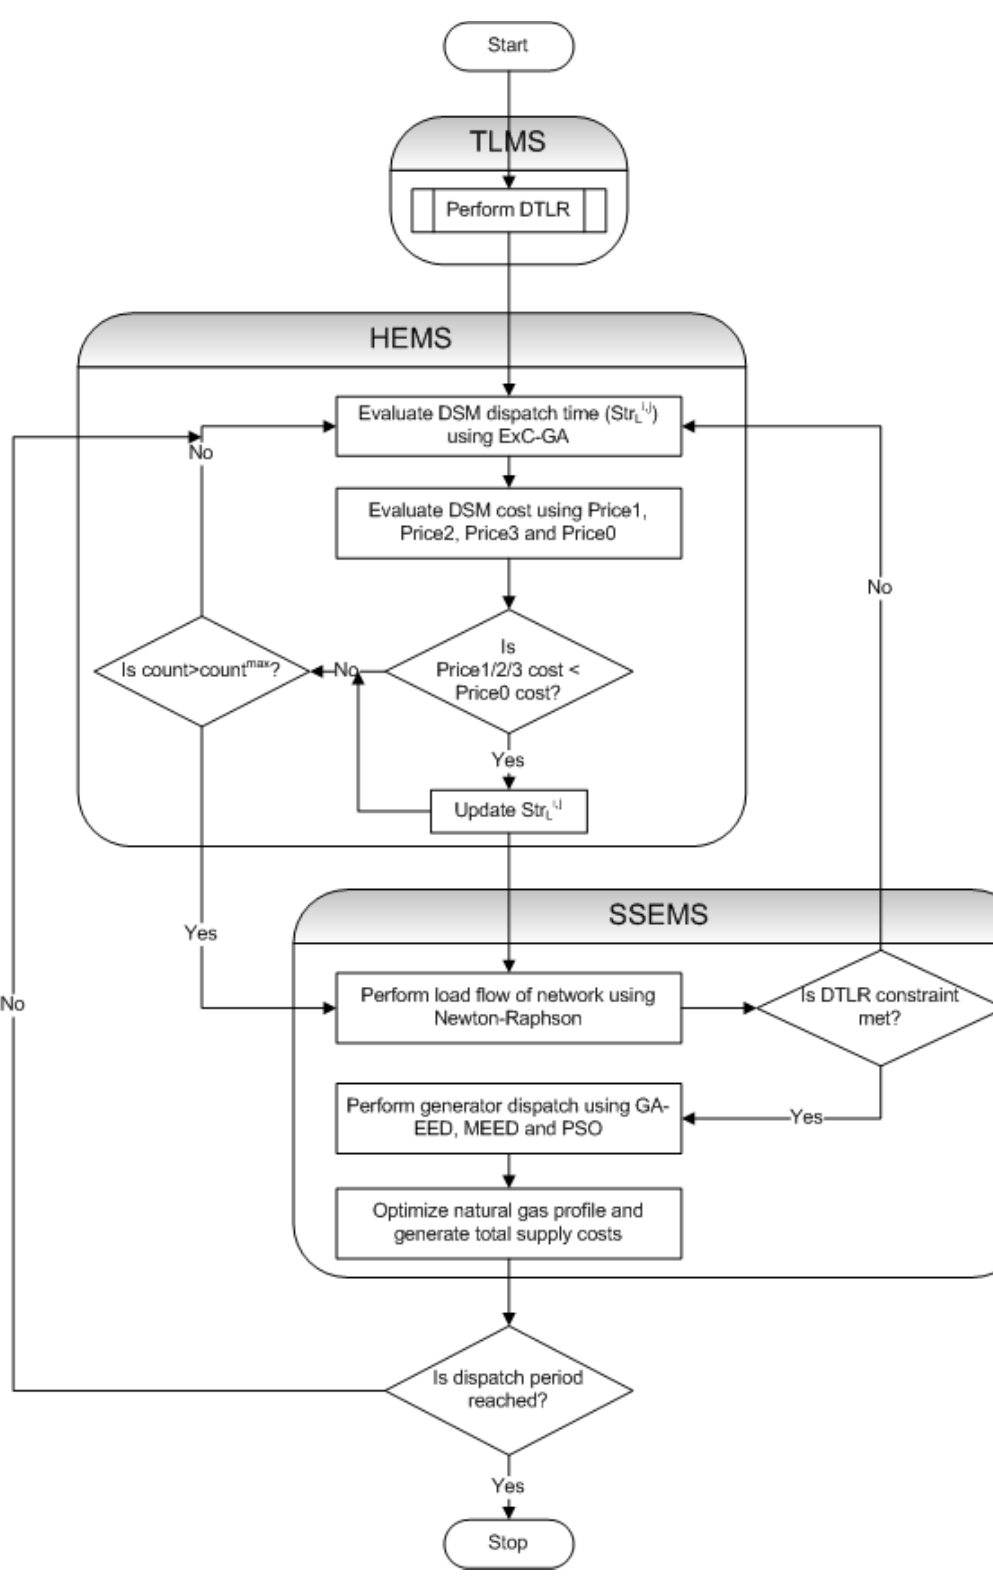
Figure 4. Flowchart of